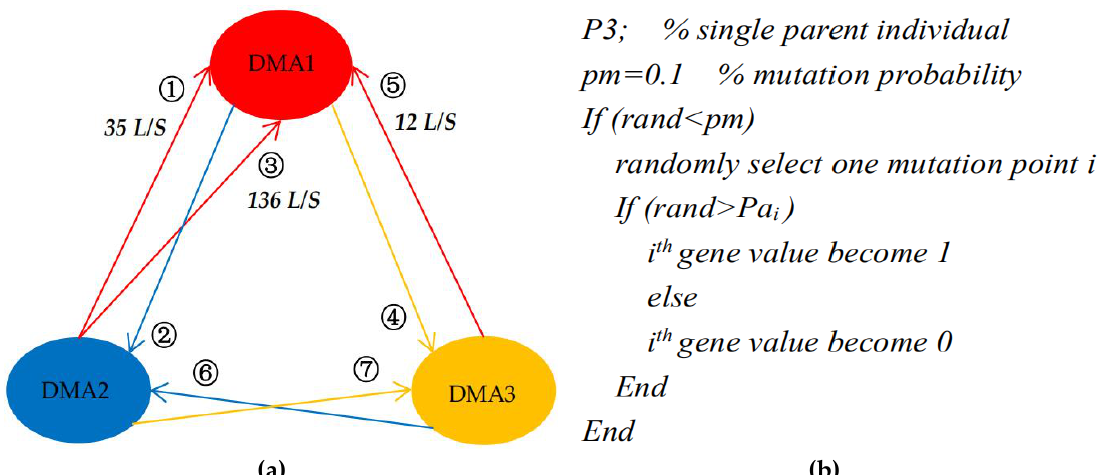
Figure 3. Mutation based on boundary pipes grouping: ( a ) illustration example of grouping; ( b ) the pseudo-code of the mutation mechanism.